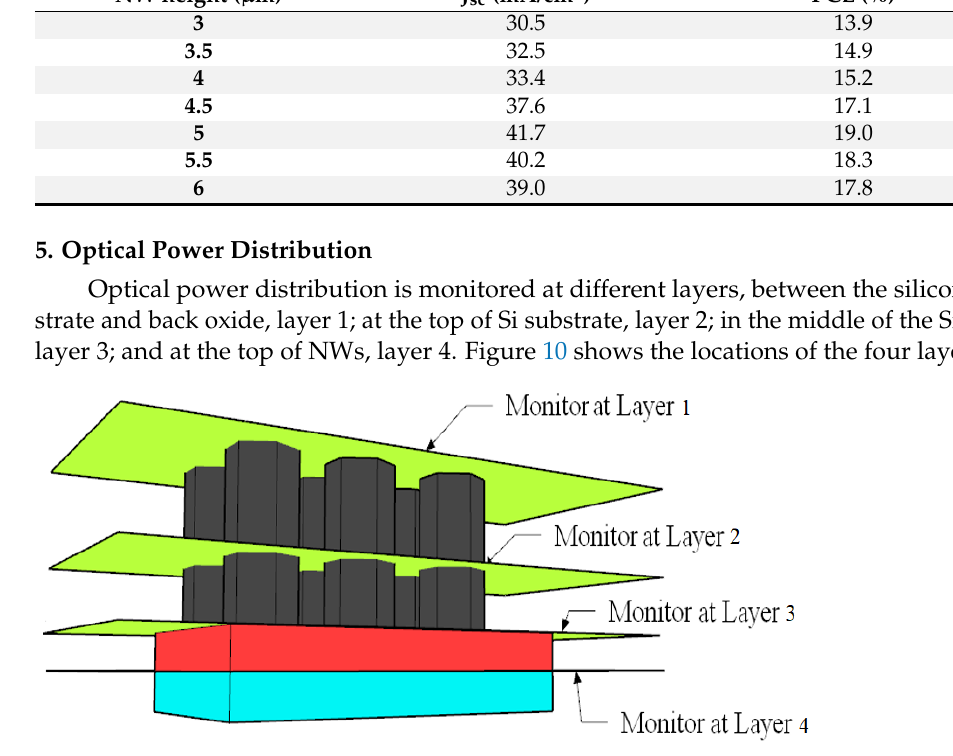
Figure 10. Different positions of electric field monitoring layers.